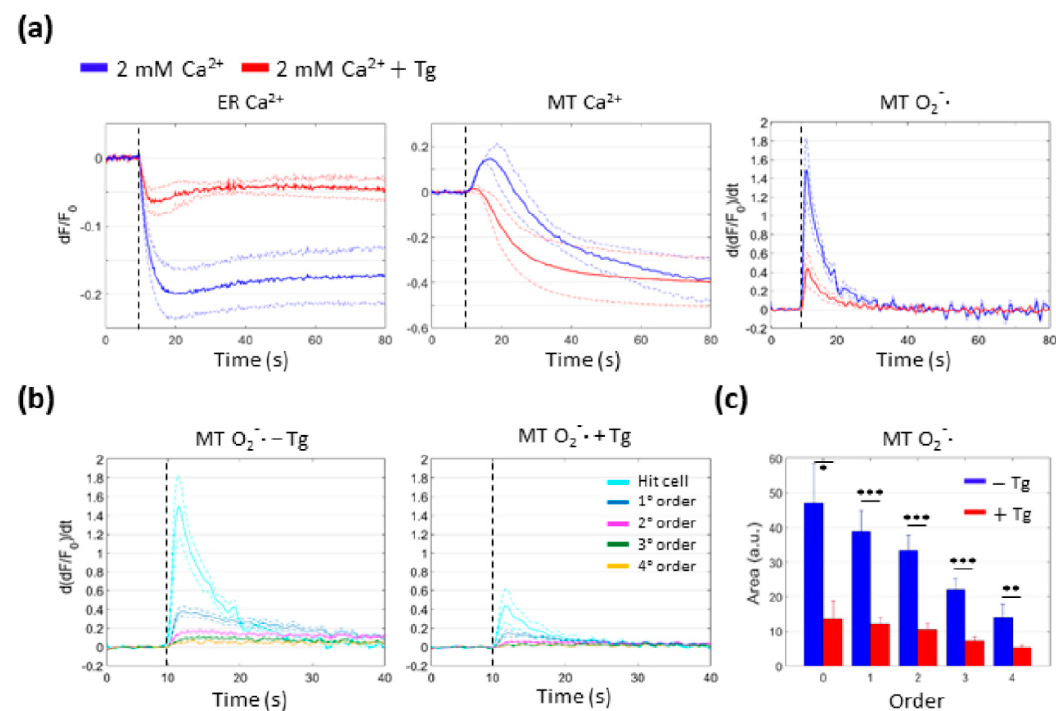
Figure 6. The extent of mitochondrial Ca 2 + uptake and O 2 − · production following PS activation depends on Ca 2 + release from the ER. ( a ) Fluorescence signals from photostimulated B16-F10 cells expressing G-CEPIA1er, a Ca 2 + biosensor targeted to the ER (ER Ca 2 + ), CEPIA2mt, a Ca 2 + biosensor targeted to mitochondria (MT Ca 2 + ), or loaded with MitoSOX Red, an irreversible selective mitochondrial O 2 − · indicator (MT O 2 − · ), obtained in the absence (blue traces) or in the presence (red traces) of Thapsigargin (Tg, 3 µ M) under SS conditions (see Materials and Methods, Section 2.2). Single-cell fluorescence traces were computed as average pixel signals within ROIs contouring the whole cell area. For ER Ca 2 + and MT Ca 2 + , shown are average dF / F 0 fluorescence traces (solid lines) ± s.e.m. (dashed lines), computed for at least n = 3 independent experiments for each condition. For MT O 2 − · , shown are average time derivatives of dF / F 0 MitoSOX Red signals (solid lines) ± s.e.m. (dashed lines) (see Materials and Methods, Section 2.6), computed for n = 6 independent experiments for each condition. Vertical dashed lines mark the onset of laser irradiation. ( b ) Mitochondrial O 2 − · production in the irradiated and bystander cells in the absence (left) or in the presence (right) of Tg. ( c ) The histogram shows mean values of the area subtended by the curves in ( b ) in the absence or in the presence of Tg for each order of bystander cells (* P < 0.05, ** P < 0.01, *** P < 0.001).